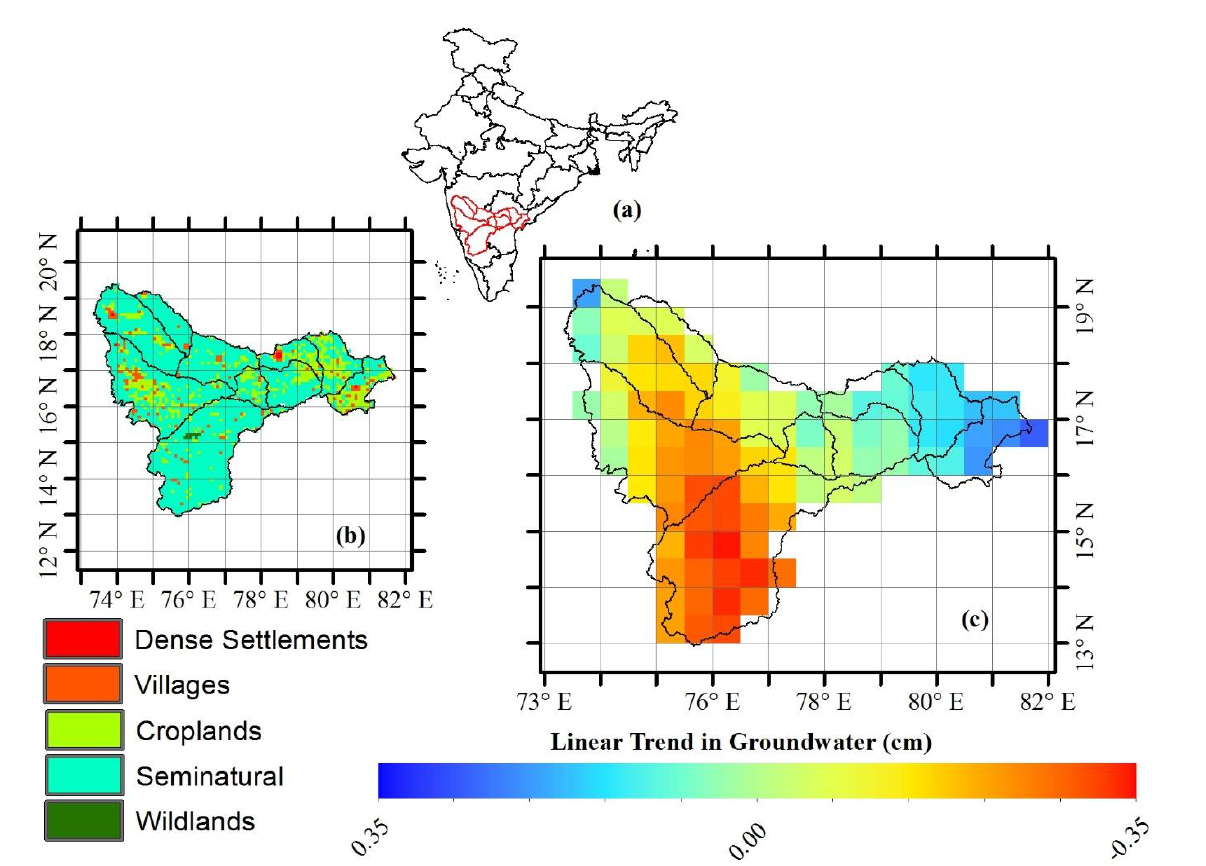
Figure 1. (a) Red lines indicate location of Krishna basin, (b) Anthropogenic Biome (For 2000, Source: Ellis et al., 2013), (c) Linear trend in groundwater derived from GRACE